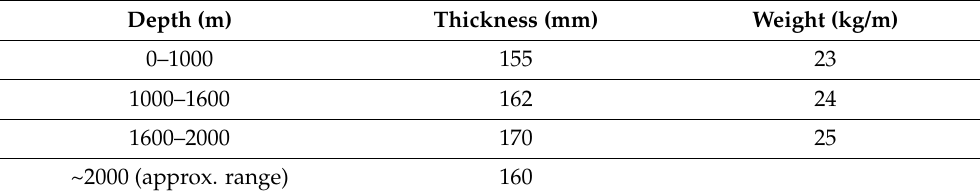
Table 13. Comparison of deep water TTR steel riser under 2000 m water depth against its structural weight. Figure 21. Comparative study at optimized angled plies for normalized structural weights and thickness.